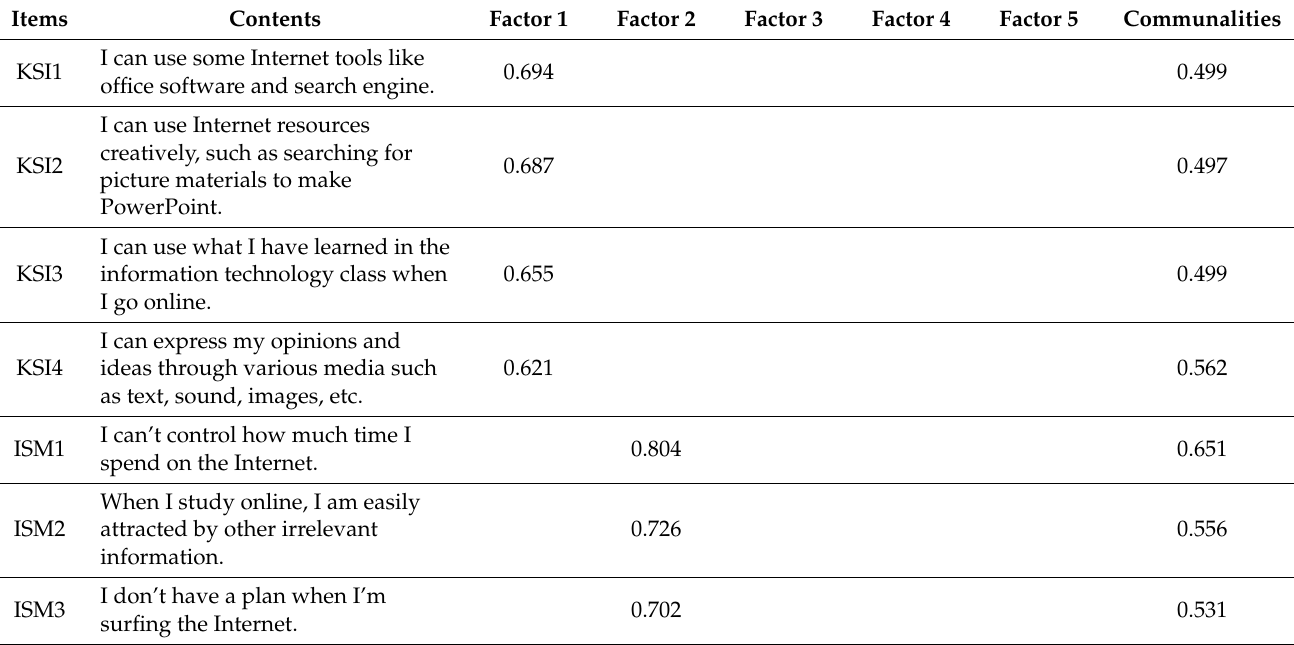
Table 5. Summary of the results from the EFA on the 18 JIL Scale items for Sample 3a ( n =